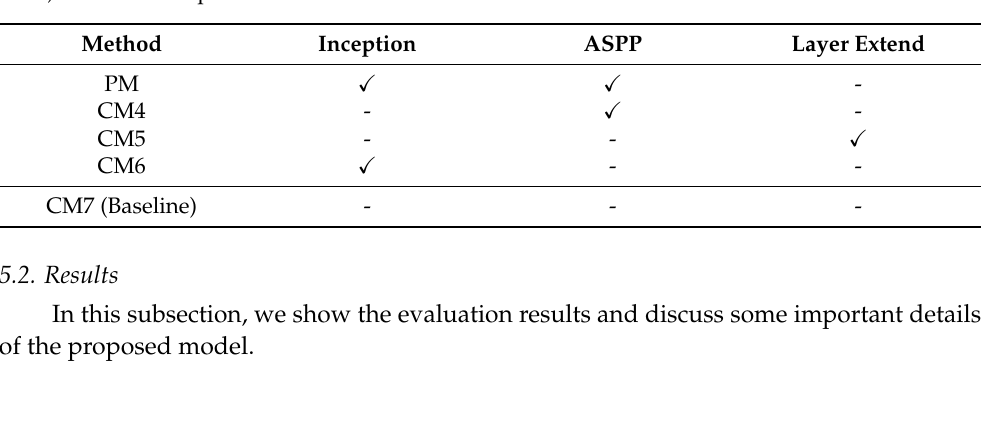
Table 2. Differences in the proposed method (PM) and U-Net-based comparative methods (CM4- CM7) used in the